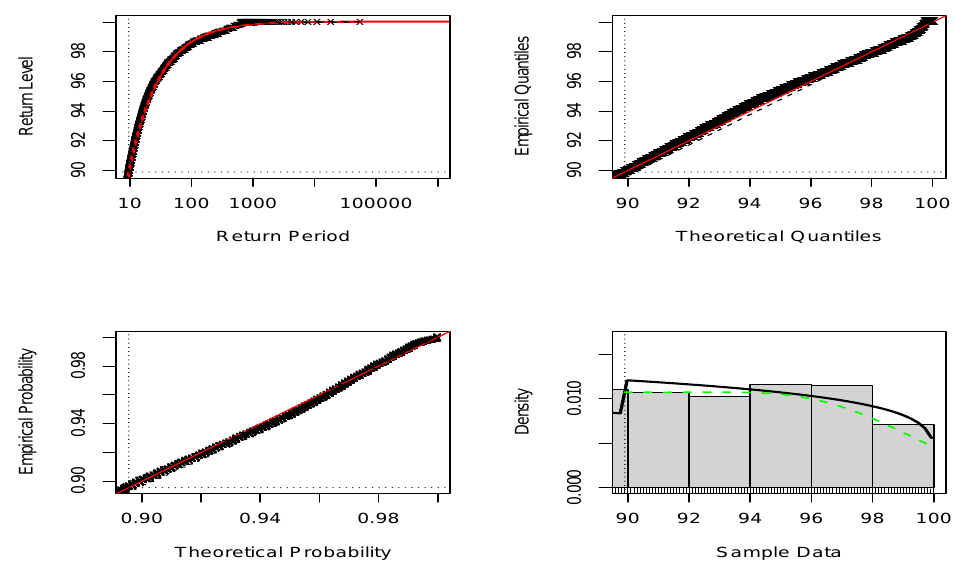
Figure A5. Diagnostic plots for fitted parameterised tail fraction of relative